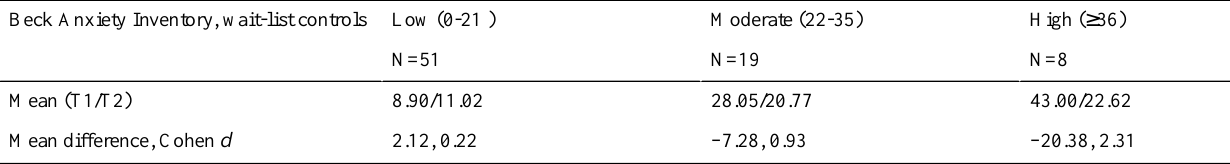
Table 10. Analysis of Beck Anxiety Inventory categories: control.